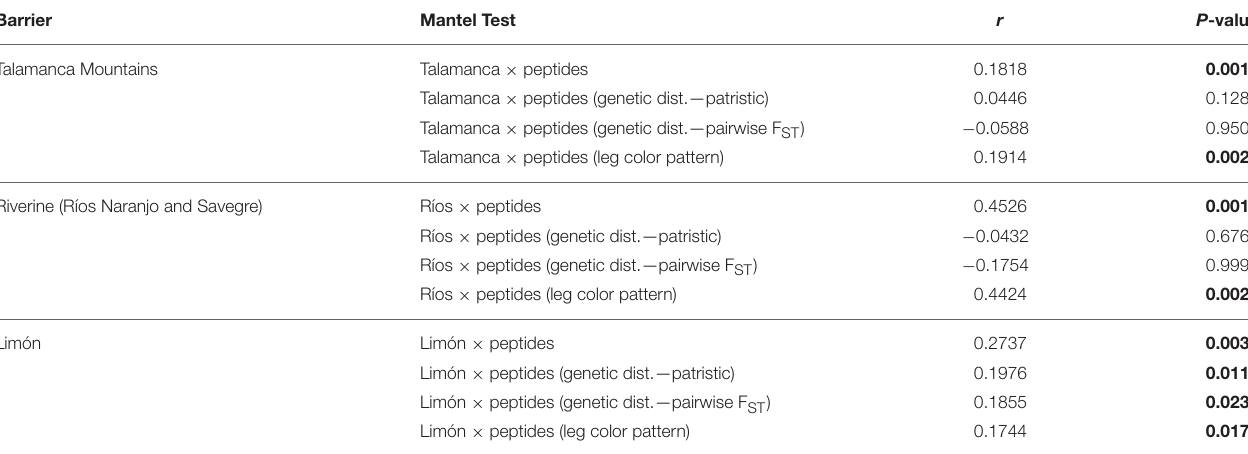
significant (p < 0.012) after Bonferonni correction are shown